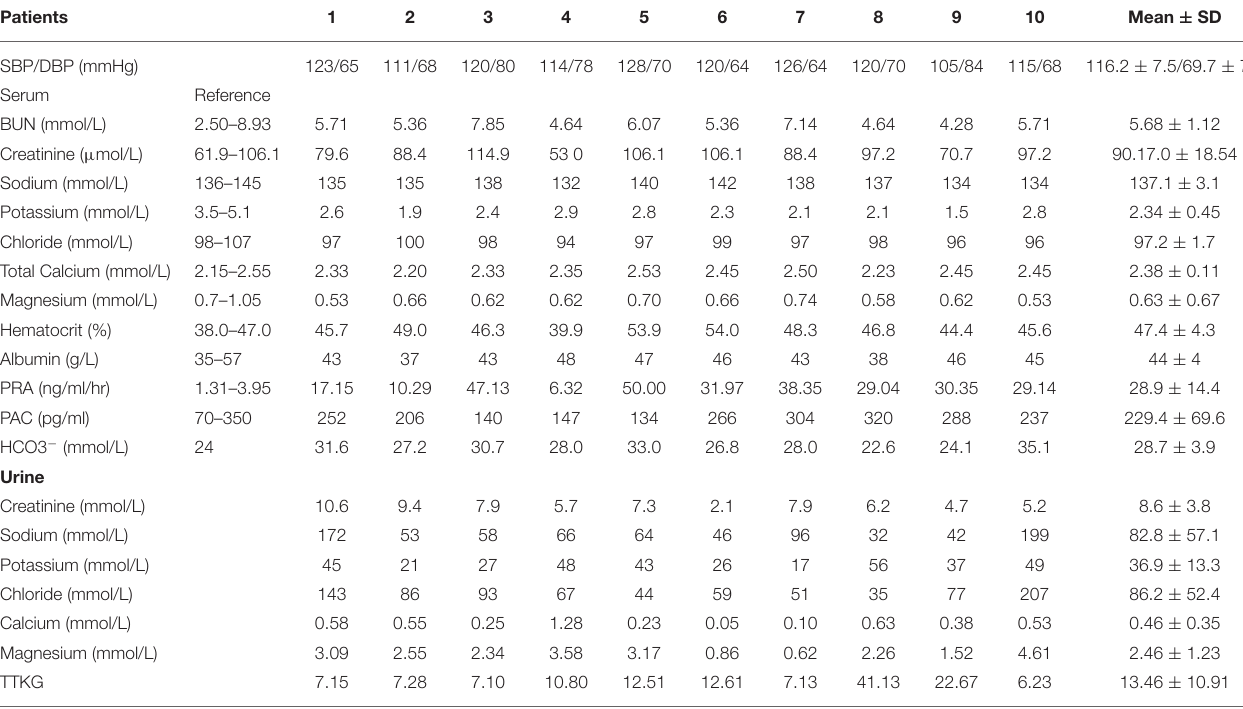
TABLE 2 | Clinical characteristics and biochemistries in patients with Gitelman syndrome.